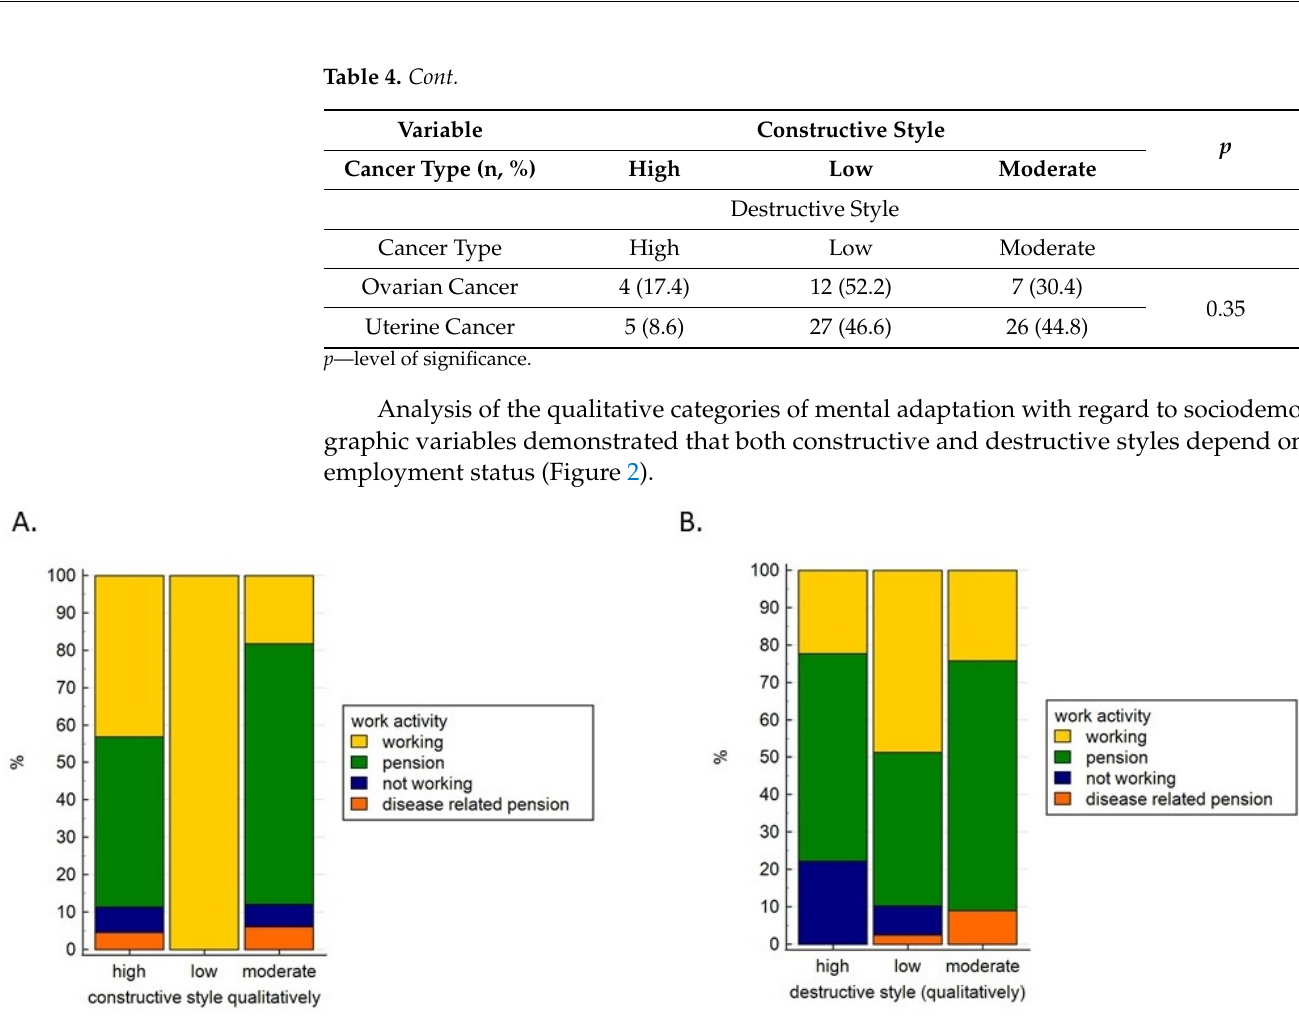
Figure 2. Qualitative mental adaptation styles constructive ( A ) and destructive ( B ) regarding present work activity constructive.